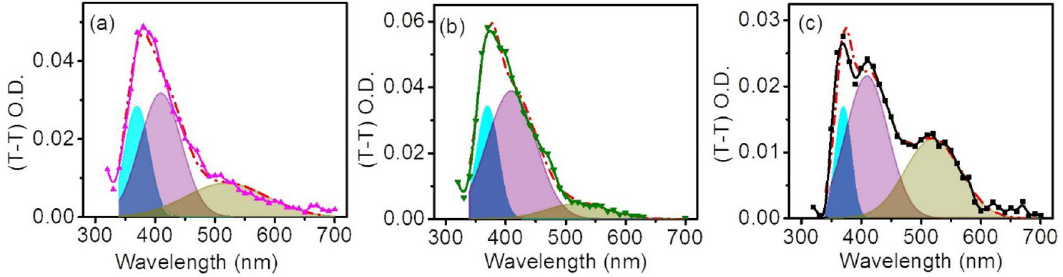
Figure 3. The de-convolution graph of the transient absorption spectra of ( a ) MQ-ADN (magenta), ( b ) Au MQ-ADN (olive) and ( c ) Fe MQ-ADN (black) respectively. Each spectrum is convoluted into three individual Gaussian functions in cyan, purple, and dark yellow color. All red lines are the fitted line to the corresponding absorption spectra at 0.5 μs time